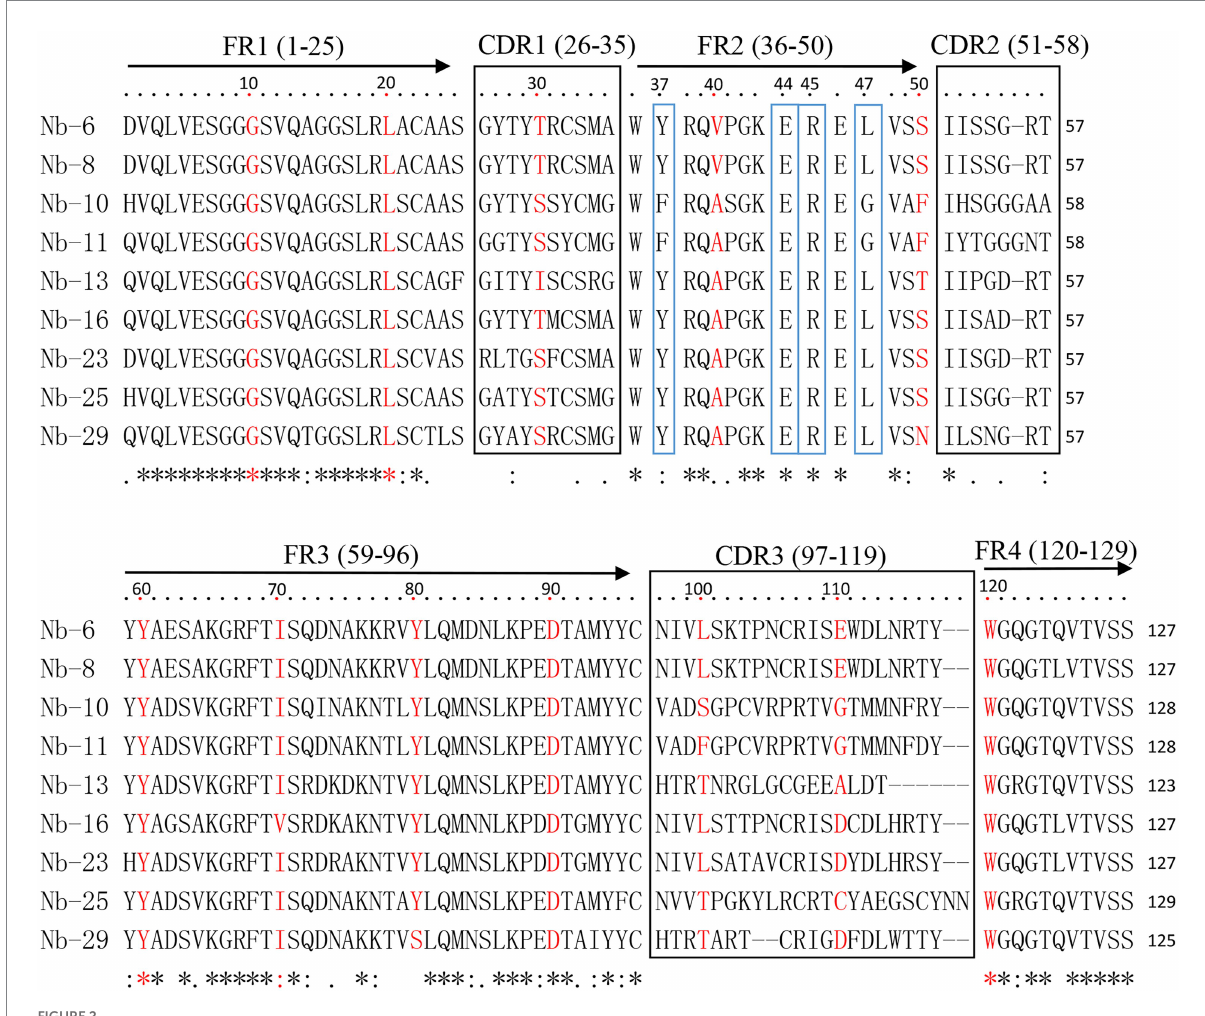
FIGURE 2 Alignment of amino acid sequence of nanobodies against ASFV p72 protein. The sequences are grouped according to their CDRs. The residues at positions 37, 44, 45, and 47 in FR2 are indicated by blue